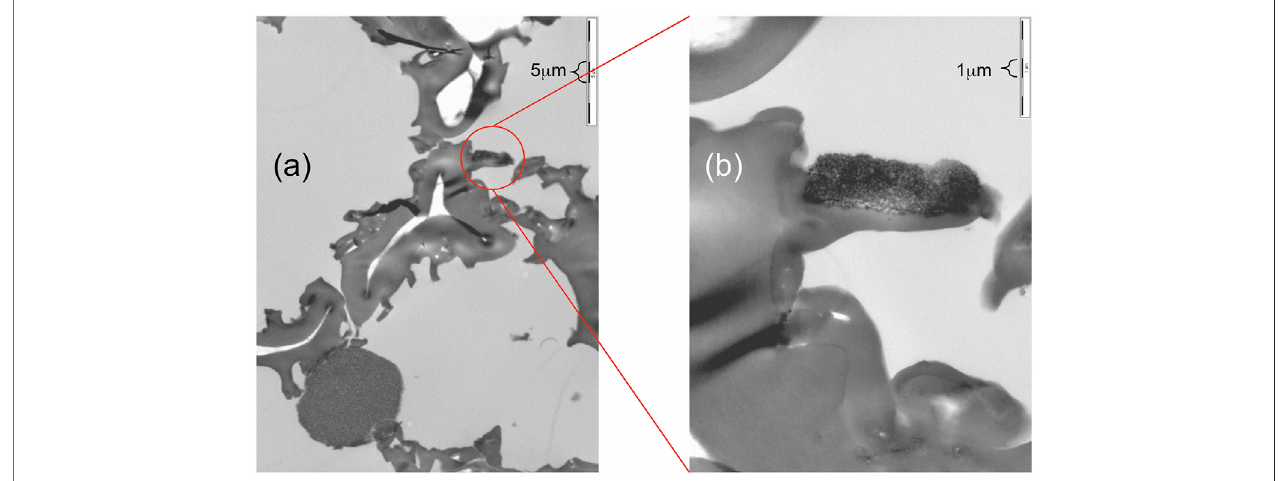
FIGURE 12 | TEM images of a MS2 microcapsule showing nanoparticles on the surfaces of the exine walls. Scale (A) 5 µm and (B) 1 µm.